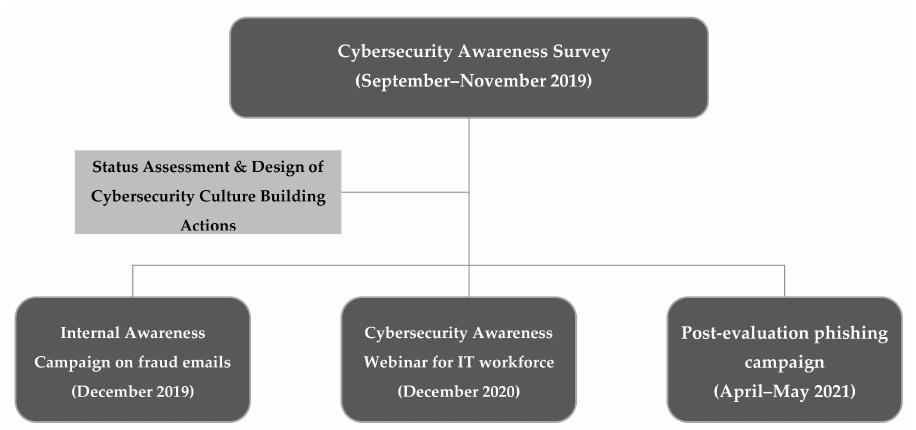
Figure 1. Cybersecurity Awareness